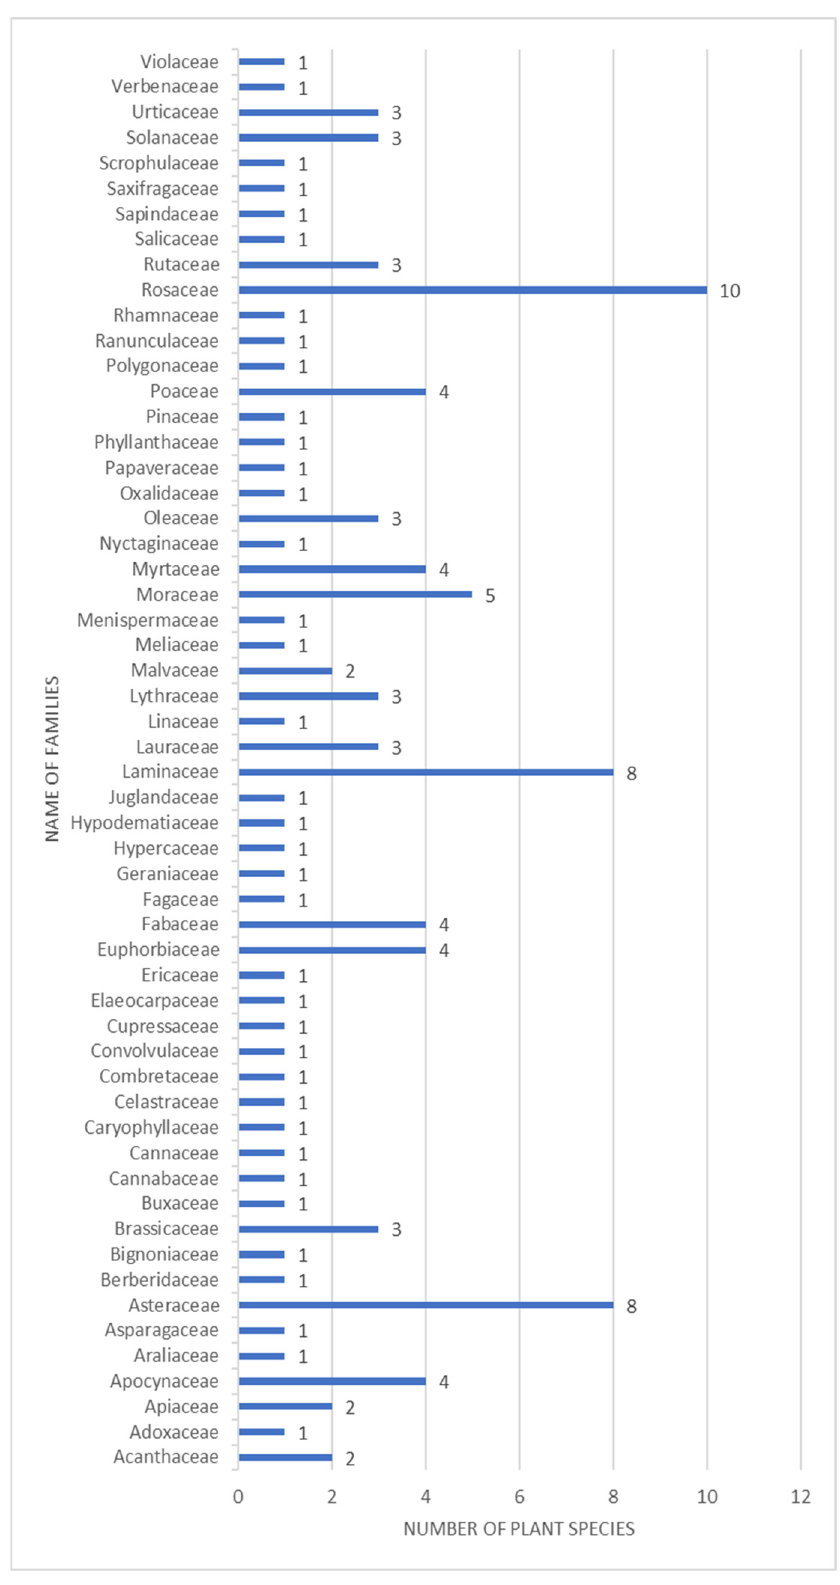
Figure 1. Bar graph showing families and exact number of plants studied during the survey. Based on the informants’ data, leaves were the most commonly used plant part, followed by whole plants, roots and flowers (Figure 2). It was also reported that in